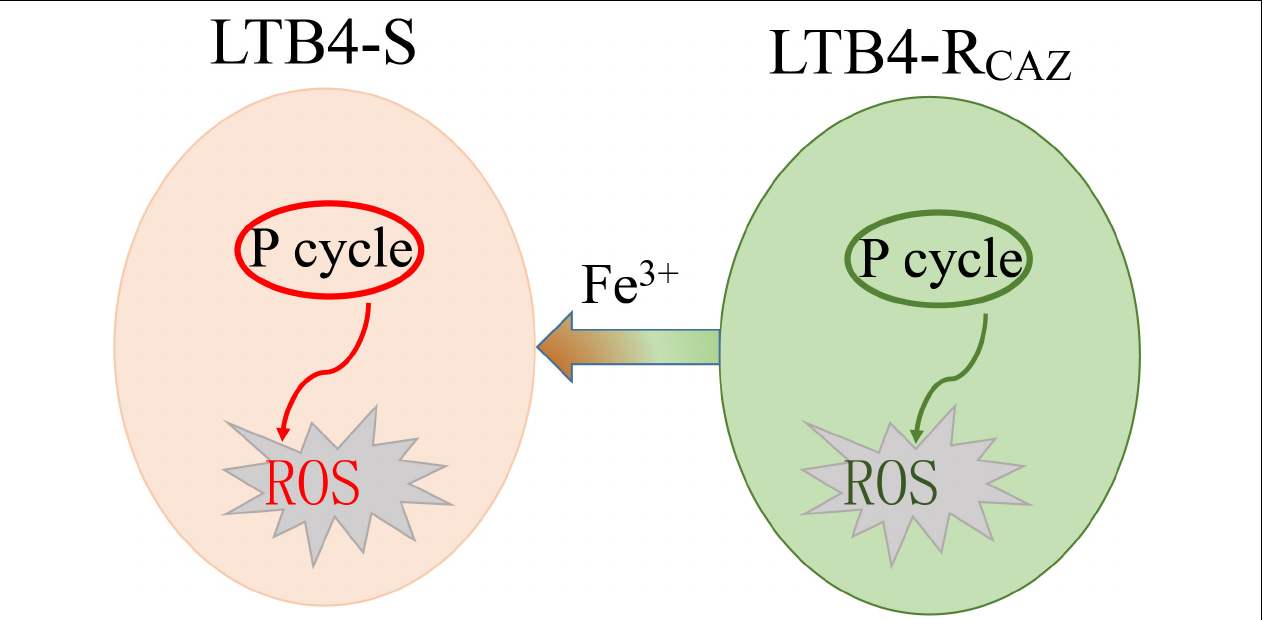
FIGURE 8 | Sketch diagram describing a mechanism by which Fe 3 + promotes ROS